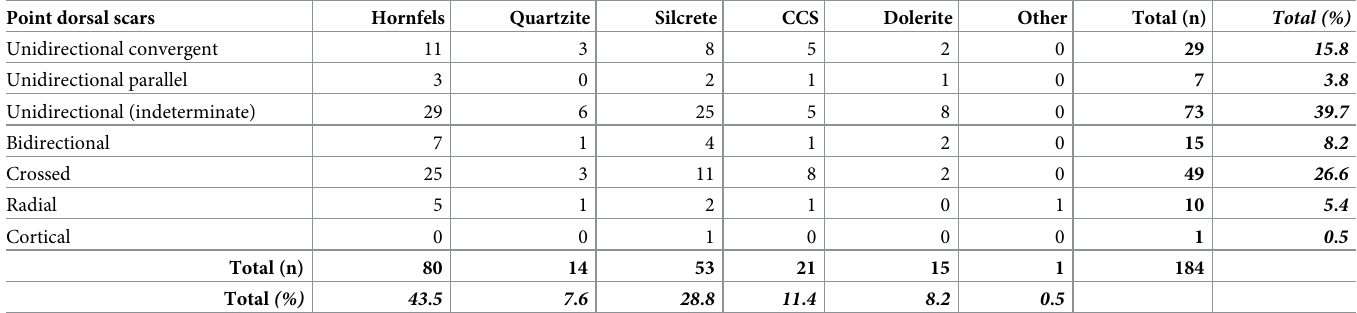
Table 10. Frequencies of point dorsal scar patterns by raw material.